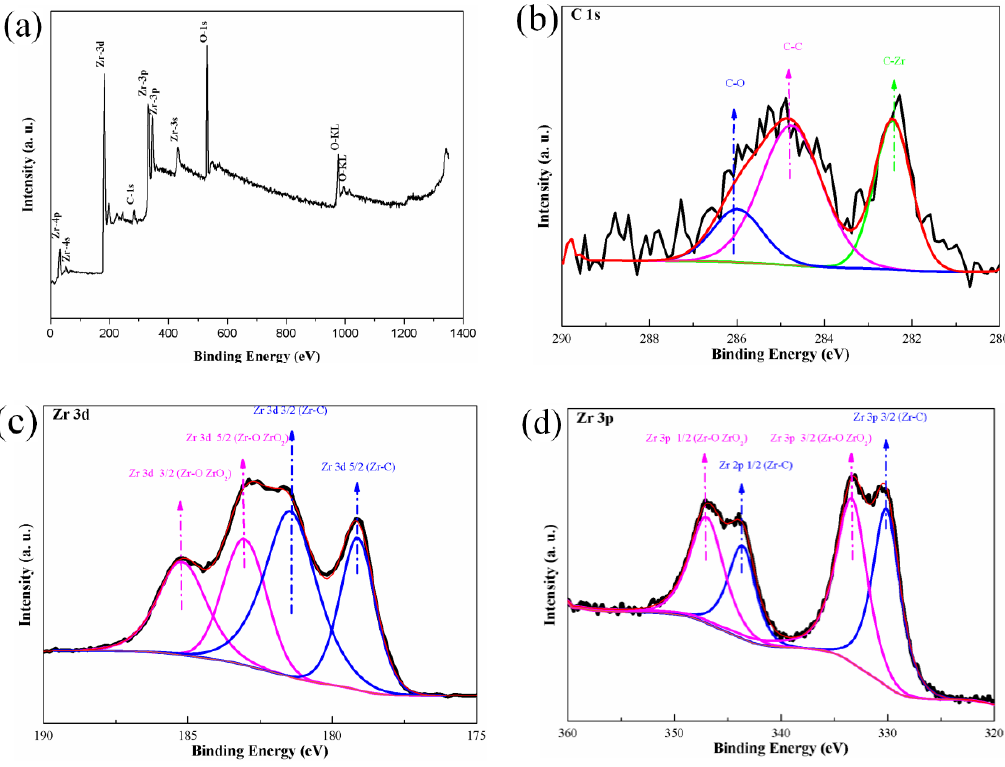
Figure 3. XPS patterns of ZrC/Zr-coated diamond particles: ( a ) full-scanning spectra; ( b ) narrow-scanning spectra of C1s; ( c ) narrow-scanning spectra of Zr3d; and ( d ) narrow-scanning spectra of Zr3p.